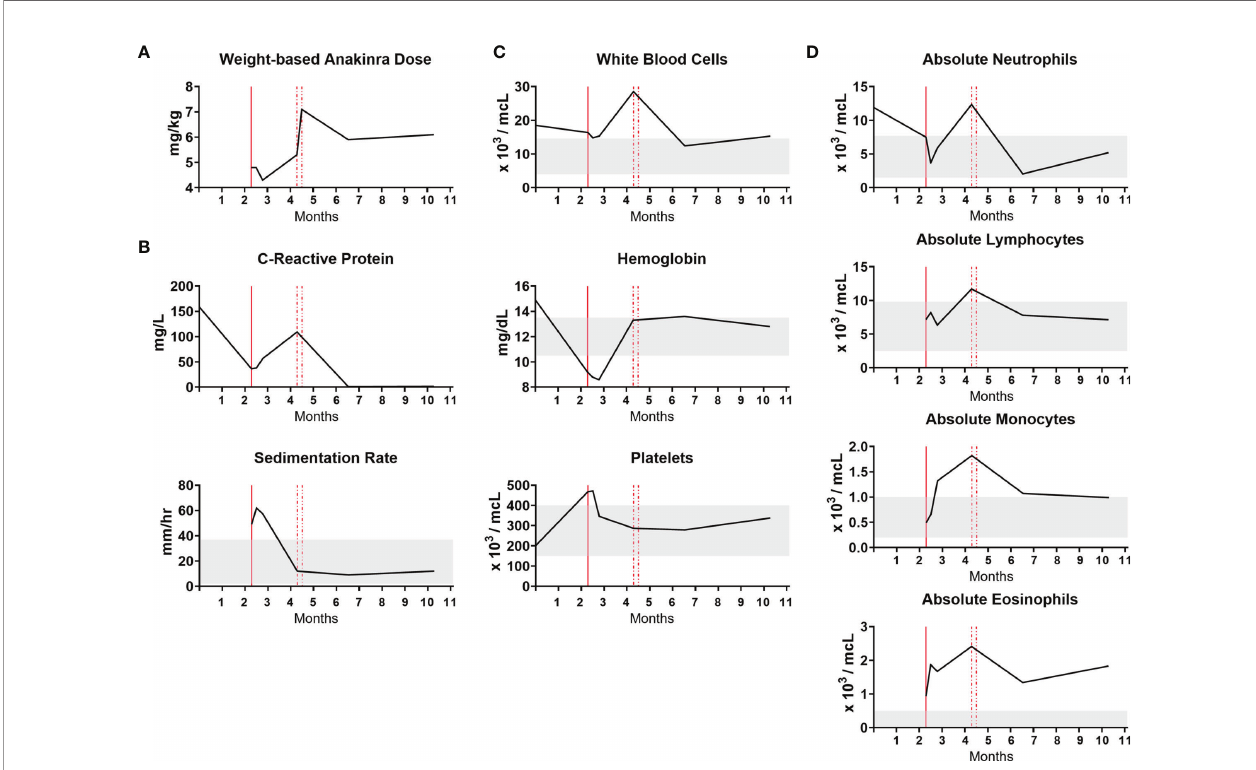
FIGURE 4 | NOMID infant response to anakinra. The x-axis is a time course in months. Vertical red lines designate initiation and then dose increases of anakinra. Gray bands indicate normal values. (A) Weight-based anakinra dosing over time. (B) Markers of in fl ammation, CRP and ESR. CRP reference range is 0.3-6.1 mg/L. (C) Complete blood count values. (D) White blood cell differential absolute